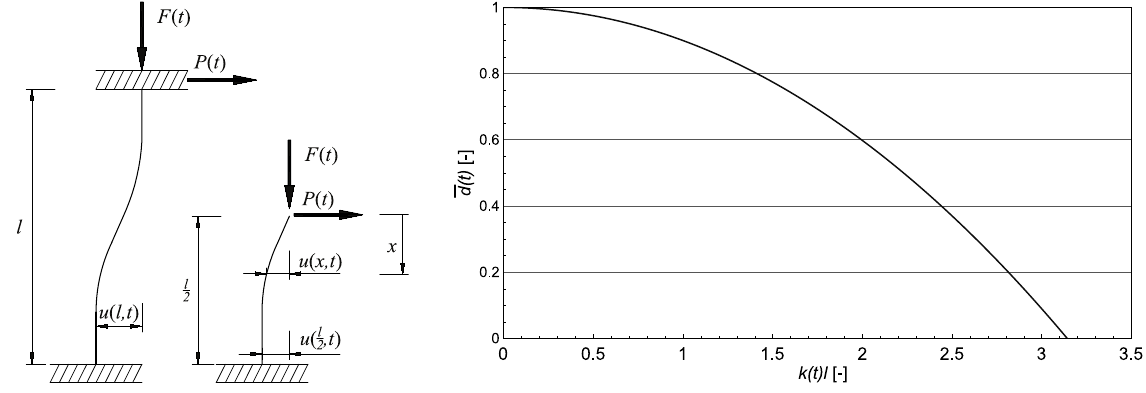
Fig. 2. Relation between the degradation parameter, ¯ d ( t ) , and k ( t ) l .